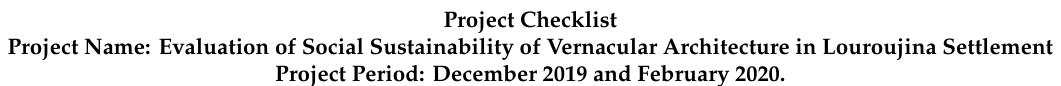
Table 16. “Social Criteria of Green Building Assessment Tool (SCGBAT)” Framework: Louroujina. Project